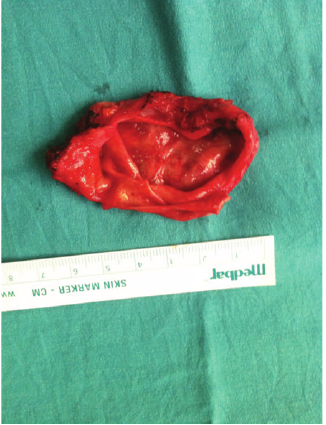
Figure 3: Resected cystic